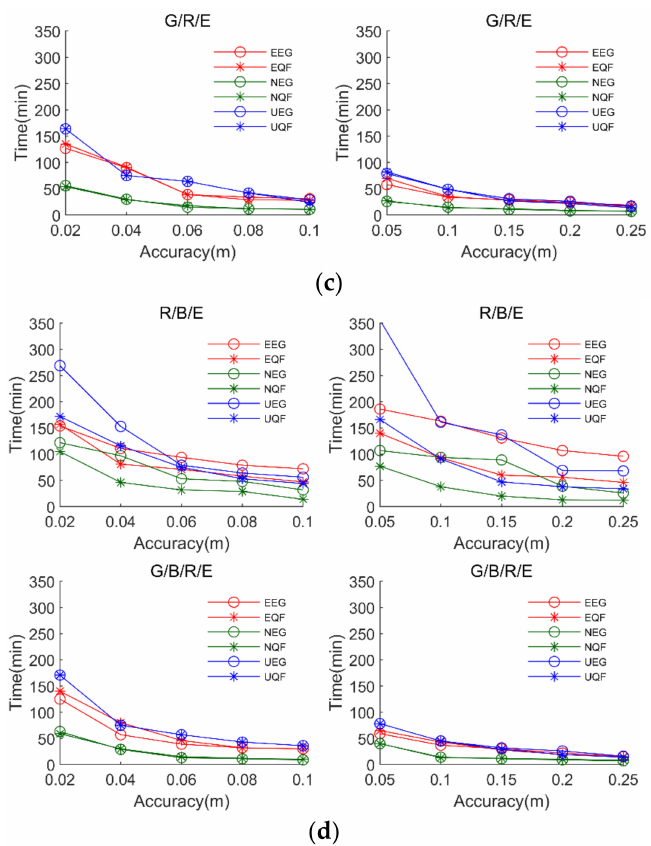
Figure 12. The corresponding time when 95% of the total stations reach the convergence accuracy in three directions. The figure includes four parts ( a – d ), and each part includes four subplots. The left column of each part shows the convergence times of the two IFCB models in static mode with different convergence accuracy requirements, while the right column of each part shows the convergence times of the two IFCB models in kinematic mode with different convergence accuracy